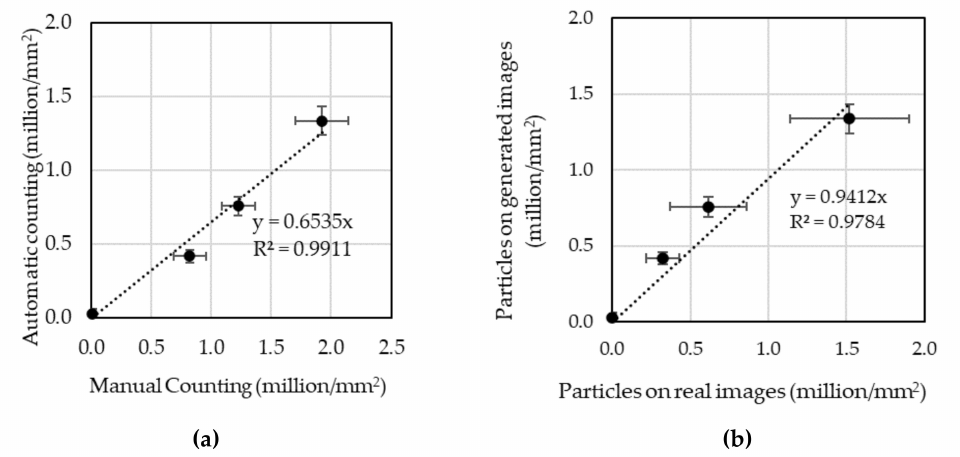
Figure 8. Particle counts on membranes at four di ff erent initial concentrations (0, 2, 5, and 8 mg / L, n = 1920 for each concentration): ( a ) comparison between the manual and automatic counts on generated images, and ( b ) comparison between the particle counts on the real and generated images by automatic counting. The bars indicate the standard